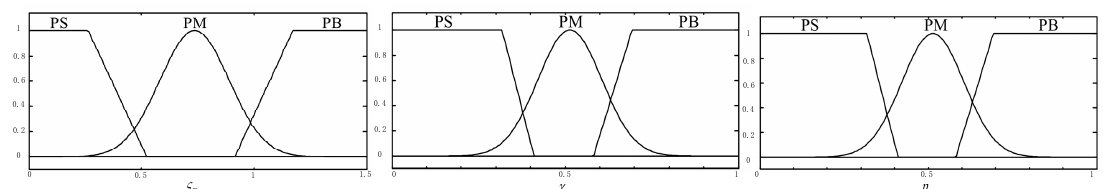
Figure 3. Fuzzy membership